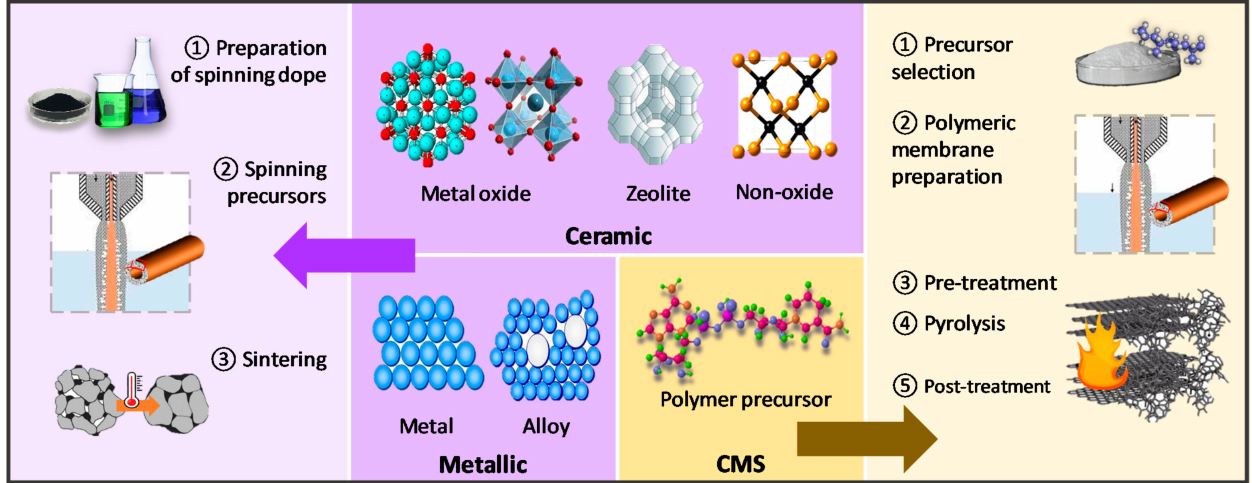
Figure 7. The categorization and preparation routes of inorganic hollow fiber